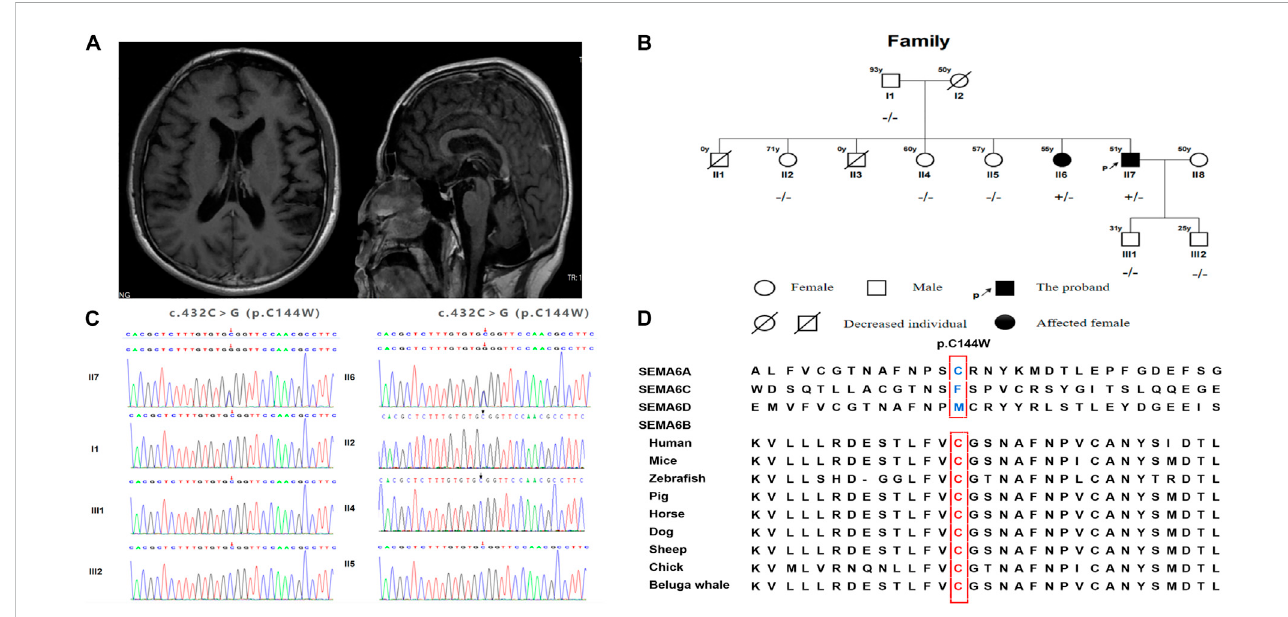
FIGURE 1 (A) Brain MRI of the proband. (B) SEMA6B gene sequencing of the family members. (C) Genetic pedigree of the family and corresponding individual genotypes. (D) The alignment of SEMA6B amino acid sequences.